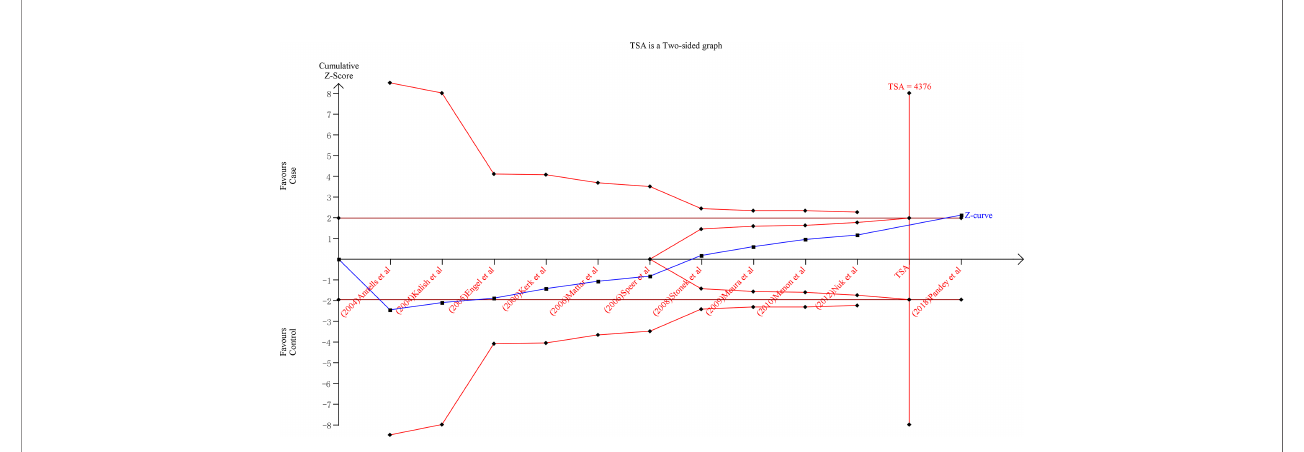
FIGURE 5 | TSA between IL-10-1082A/G(rs1800896) polymorphism and PTB risk (AA+GG